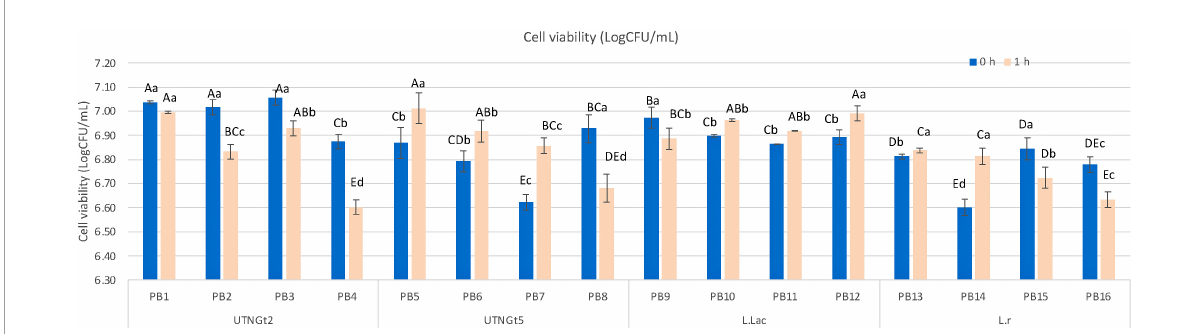
FIGURE2 Cell viability (logCFU/ml) comparison of PBs beverages obtained without fermentation (0 h) and fermentation step (1 h). Bars are the means ± standard error. Values with different letters are significantly different p < 0.05. Capital letters show the differences within the method (Duncan’s test). Small letters show the differences within the formulation-with and without cocoa (LSD with Bonferroni correction). Legend: PB1–PB4: (CSMF1–CSMF4) + UTNGt2; PB5–PB8: (CSMF1–CSMF4) + UTNGt5; PB9–PB12: (CSMF1–CSMF4) + L.Lac; PB13–PB16: (CSMF1–CSMF4) + L.r. CSMF1: semi-skimmed milk + 1% cocoa + 2% glucose; CSMF2: semi-skimmed milk + 2% cocoa + 2% glucose; CSMF3: semi-skimmed milk + 3% cocoa + 2% glucose; CSMF4: semi-skimmed milk + 2%